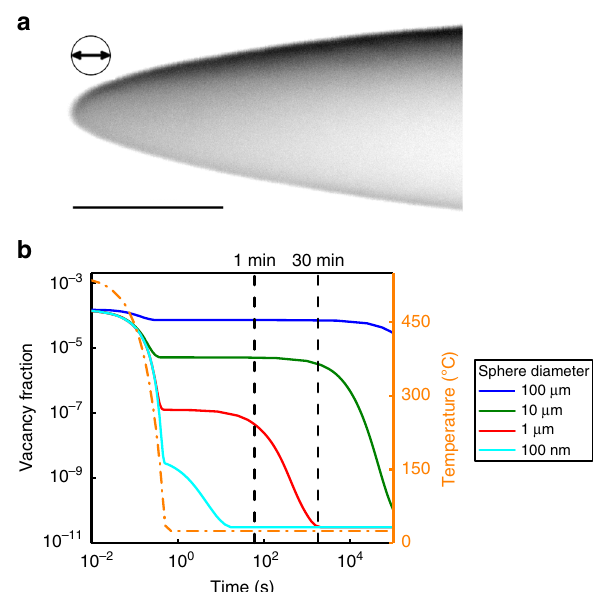
Fig. 3 Simulation of the nonequilibrium vacancy evolution. a Inverted scanning electron microscopy (SEM) image of the APT sample nano_aged_01 before the measurement. The scale bar length corresponds to 500 nm and the diameter of the shown circle is 85 nm. b Calculated nonequilibrium vacancy fraction over time and temperature upon quenching and subsequent natural aging for pure Al (FSAK model 31 ). A sphere diameter is used as a simpli fi ed model for the APT specimen. The nonequilibrium vacancy fraction formed upon quenching and its preservation at RT decays rapidly with decreasing dimensions. Additional lines for 1 min and 30 min are added as visual guidelines